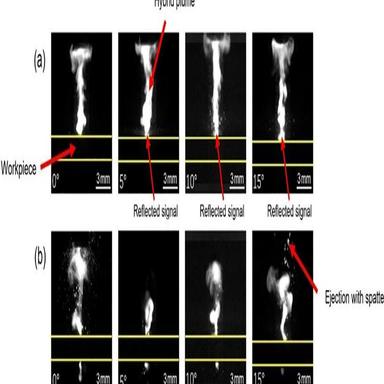
Photography effects for (a) blind-hole drilling using the first laser pulse and (b) through-hole drilling using the second laser pulse captured using different camera shooting angles without assist gas (peak laser power density: 1.51 × 106 W/cm2 ).